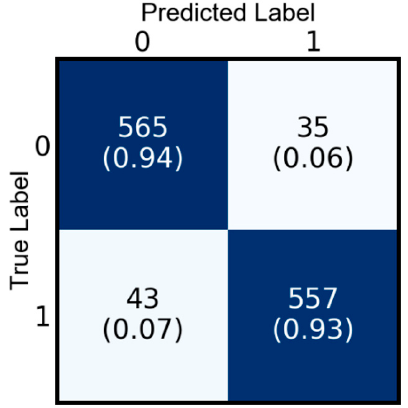
Figure 10. Confusion matrix of model 2, generated using the test dataset, showing results of binary classifications between benign (0) and malignant (1) tumors. Blue boxes at top-left and bottom-right represent true positive and true negative, respectively; white boxes at top-right and bottom-left represent false negative and false positive, respectively. Table 5. Comparative analysis of lightweight and pre-trained CNN models based on non-handcrafted features. Metrics are for the test dataset.